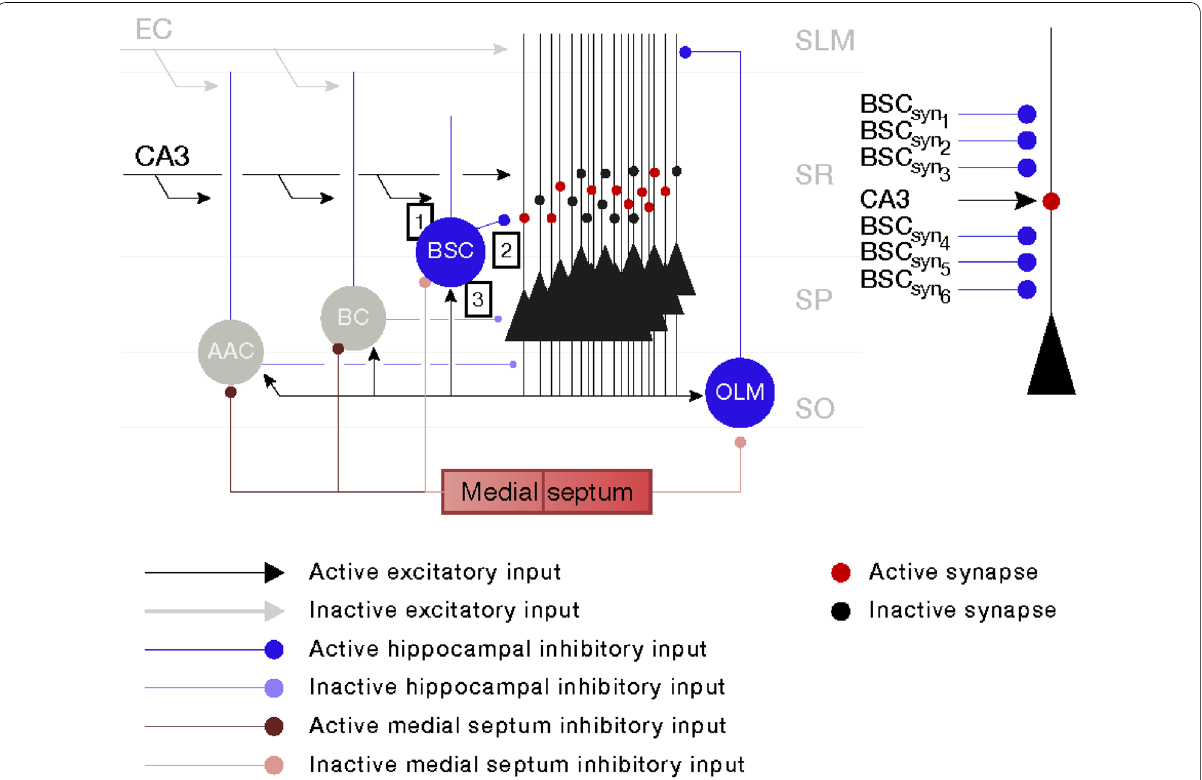
Fig. 2 (Left) Recall microcircuit model of region CA1 of the hippocampus and (right) CA1-PC model with one excitatory (CA3) and six inhibitory (BSC) synaptic contacts on its dendrites. EC: entorhinal cortical input; CA3: Schaffer collateral input; AAC: axo-axonic cell; BC: basket cell; BSC: bistratified cell; OLM: oriens lacunosum-moleculare cell; SLM: stratum lacunosum-moleculare; SR: stratum radiatum; SP: stratum pyramidale; SO: stratum oriens. During recall, only PCs, BSC, and OLM cell are active. AAC and BCs are inactive due to strong medial septum inhibition. BSC and PC are driven on their SR dendrites by a strong CA3 excitatory input, which represented the contextual information. EC input is disconnected from the network, which thus has no effect on it. Red circles on PC dendrites represent loaded synapses, whereas black circles on PC dendrites